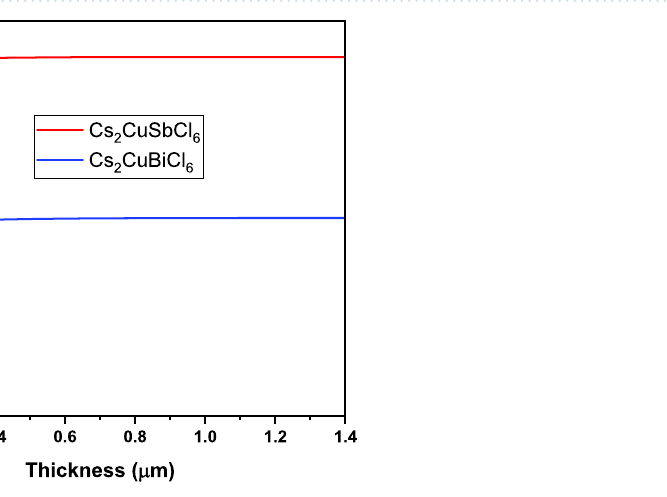
Figure 8. Variation of spectroscopic limited maximum efficiency (SLME) as a function of thickness of absorbing